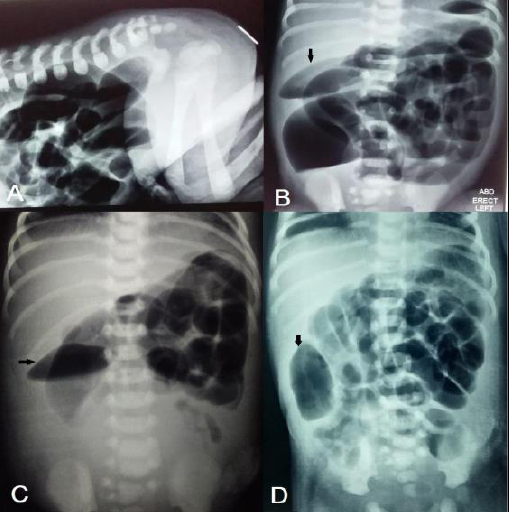
Figure 1: A) Cross table lateral film showing high anorectal malformation. B) Preoperative erect radiograph showing a fusiform area (arrow). C) Postoperative erect radiograph showing the same finding (arrow). D) Postoperative supine radiograph showing the same finding